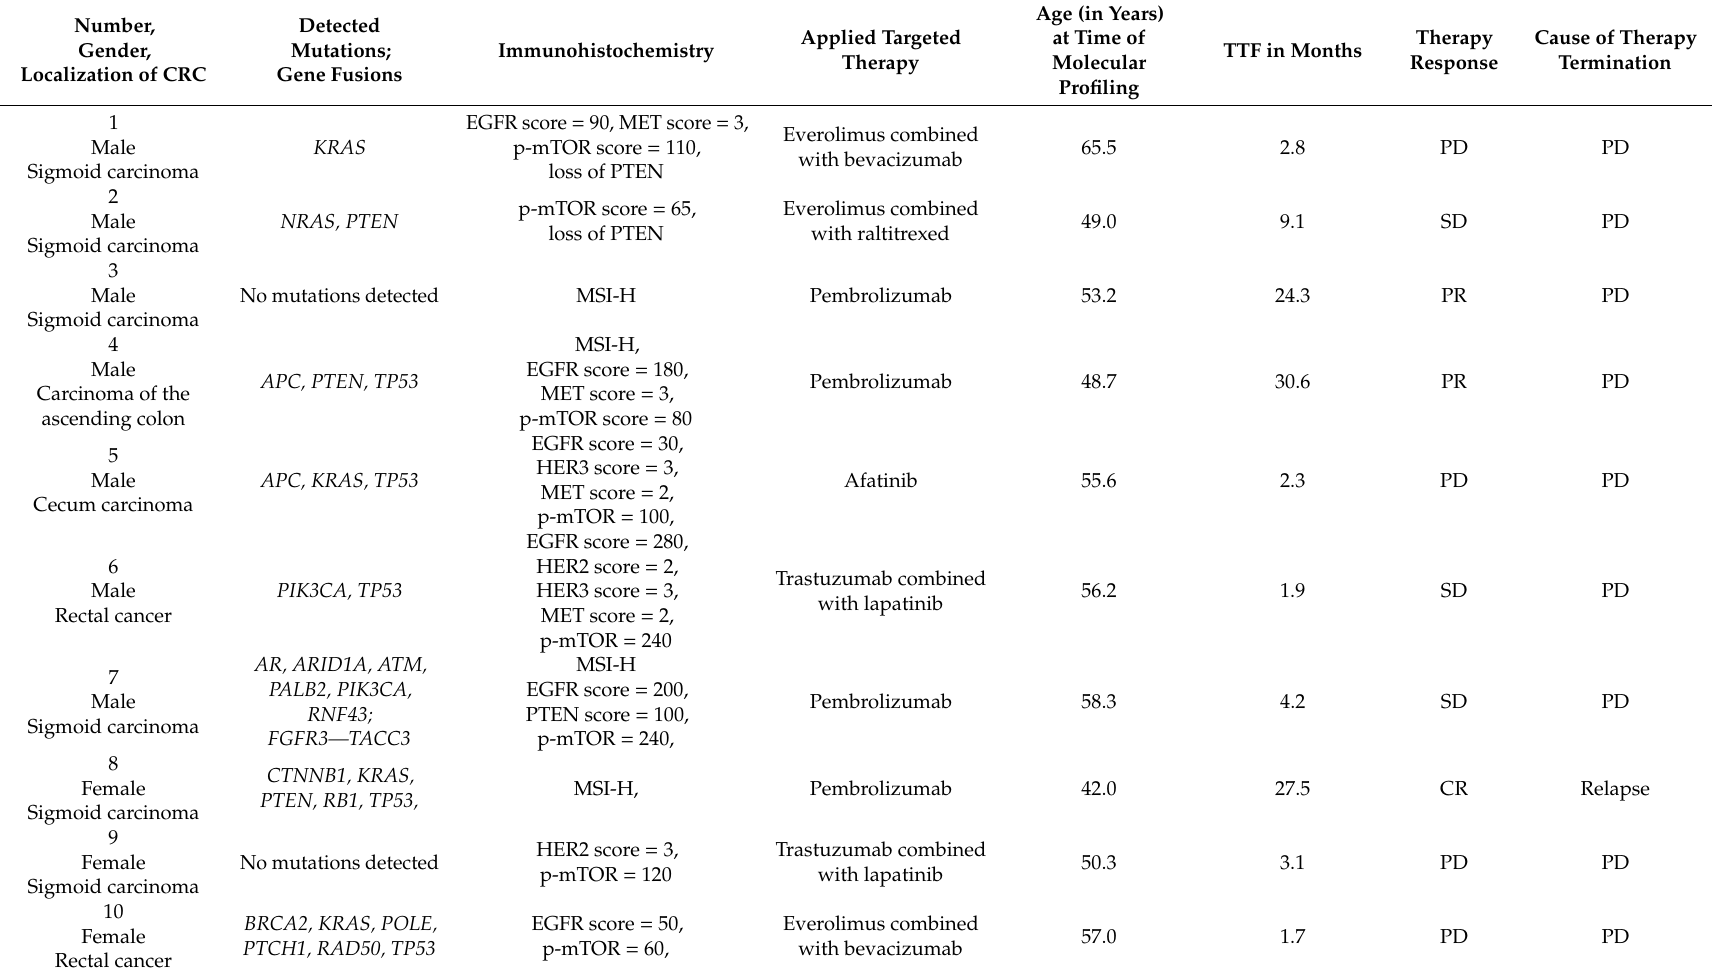
Table 4. Characteristics of the CRC patients receiving the molecular-based targeted therapy recommendation ( n =